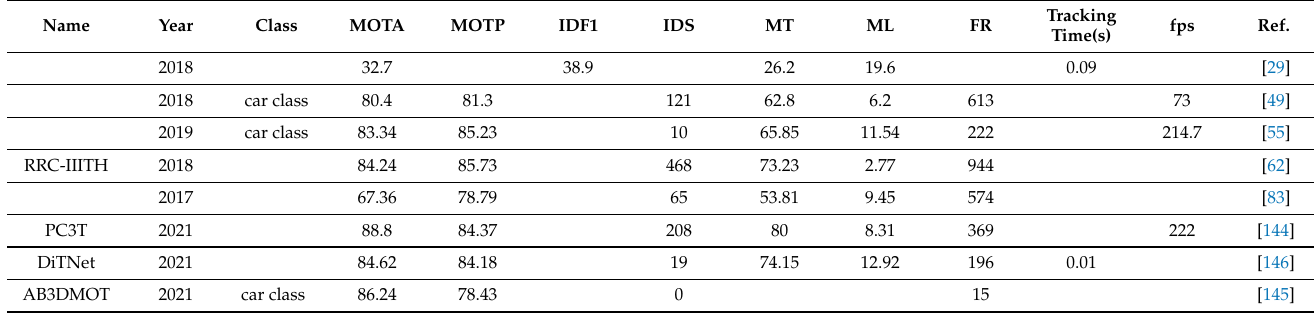
Table 3. The previous state-of-the-art models on the KITTI